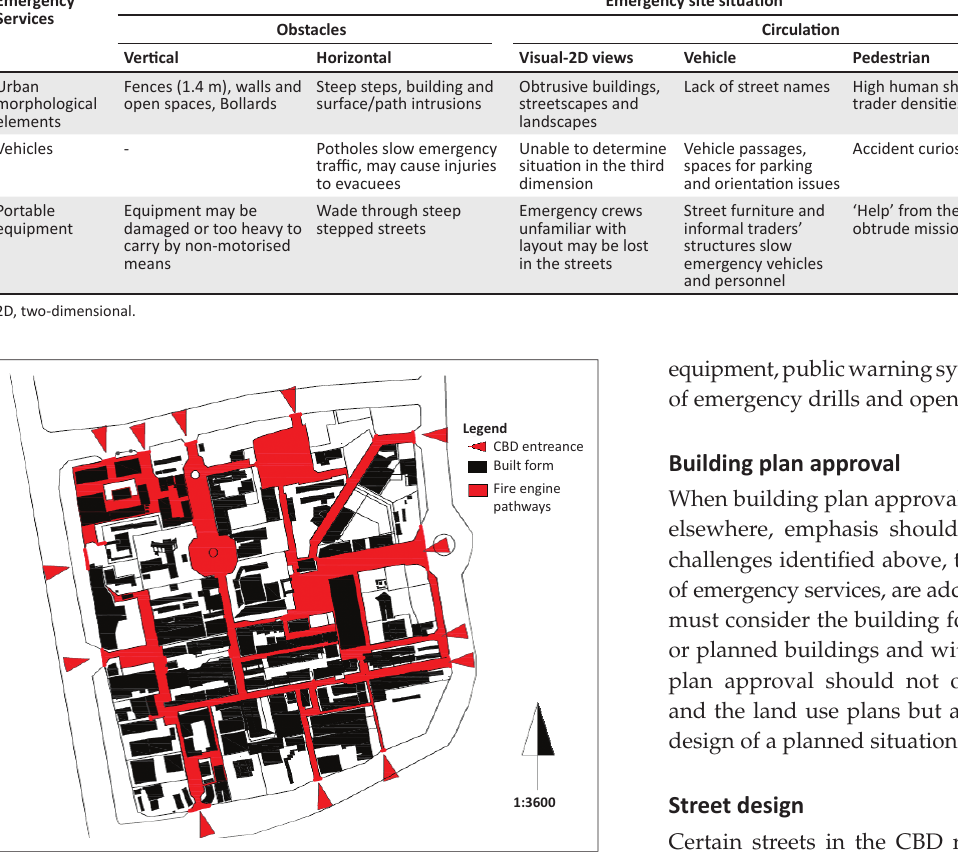
FIGURE 10: Fire engine pathways. CBD, central business district.